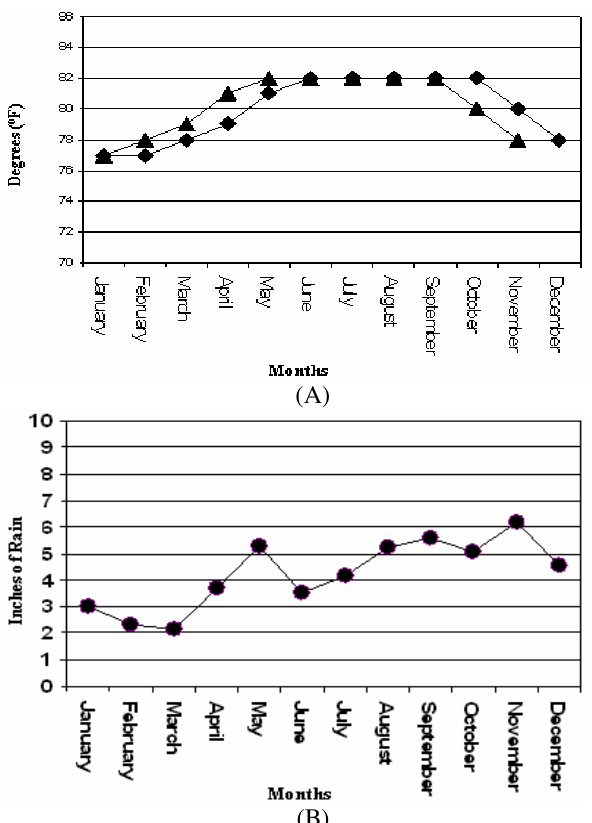
Figure 2: Temperature (A) and precipitation (B) profile for the municipality of Carolina, Puerto Rico. Data was kindly provided by the National Weather Service and the National Oceanic and Atmospheric Agency (NOAA) through the